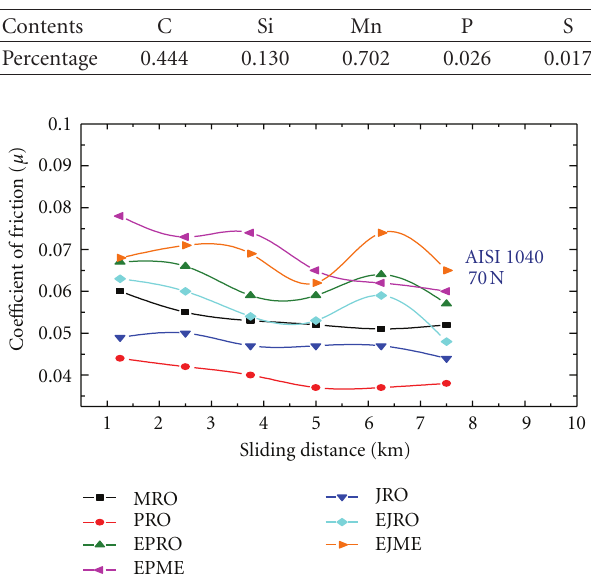
Table 3: Compositions of AISI 1040.